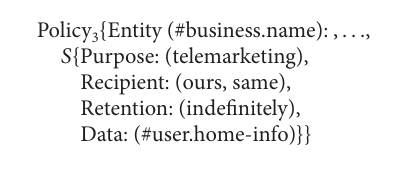
Algorithm 5: P3P privacy policies of threesingleservices (Policy